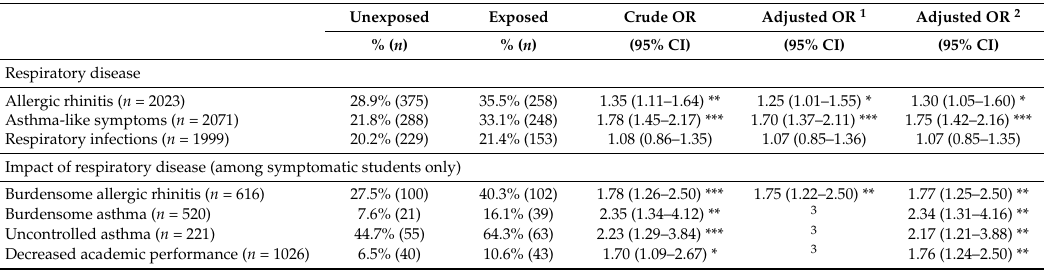
Table 3. Crude and adjusted association between residential exposure to dampness or mold and self-reported respiratory diseases (in the last 12 months) among university students (unweighted data, n = 2097). Unexposed Exposed Crude OR Adjusted OR 1 Adjusted OR 2 % ( n ) % ( n ) (95% CI) (95% CI) (95% CI) Respiratory disease Allergic rhinitis ( n =